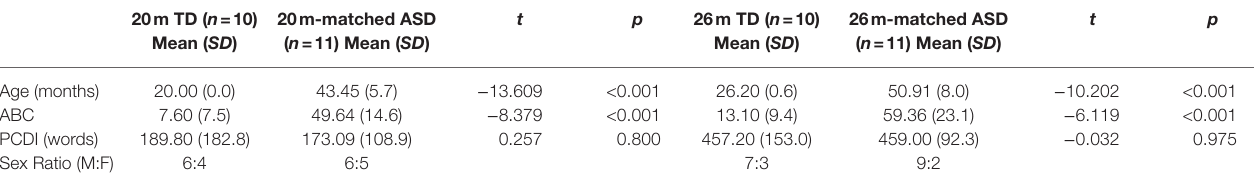
TABLE 2 | Participant